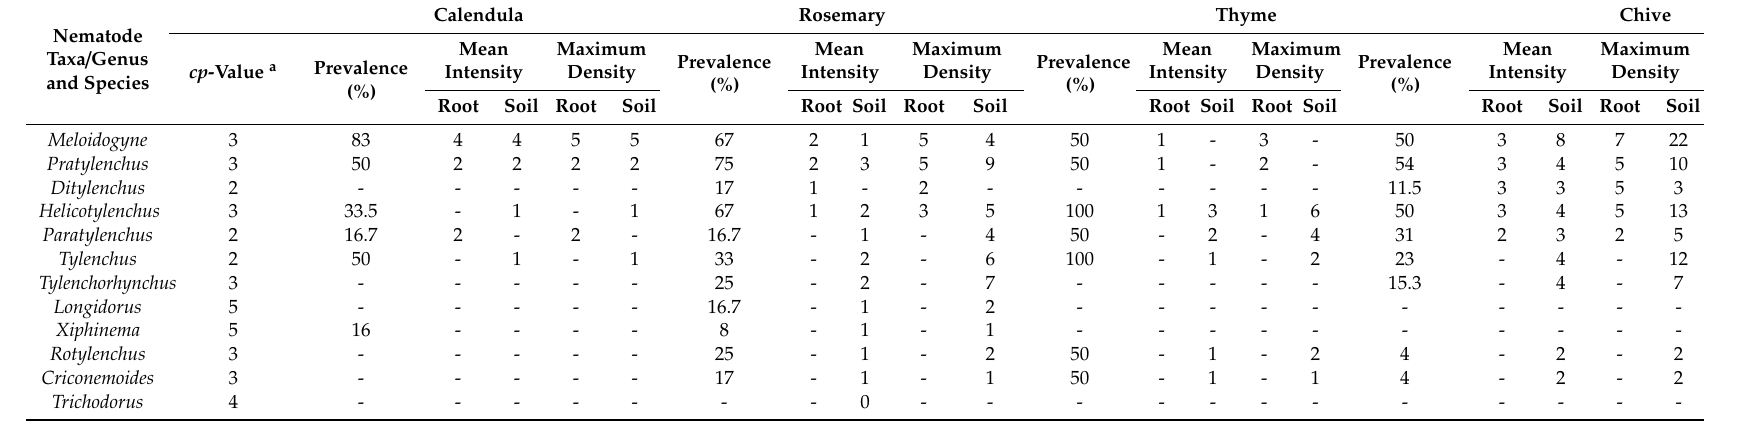
Table 4. Prevalence, mean, and maximum density of plant parasitic nematodes from soil (100 cm 3 ) and root (20 g) of medicinal crops and aromatic plants in Southern Morocco (survey January